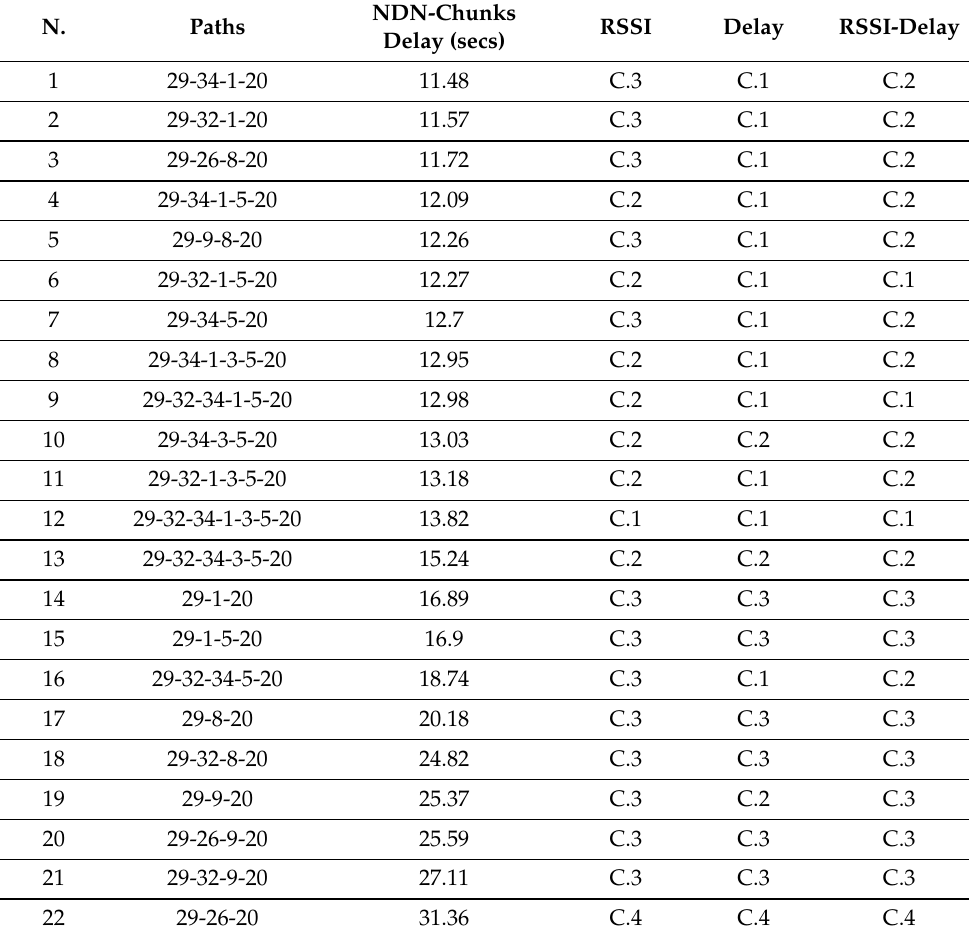
Table 7. Comparison of the clustering results, considering the average delay (secs) of 1MB file transfer using NDN-Chunks